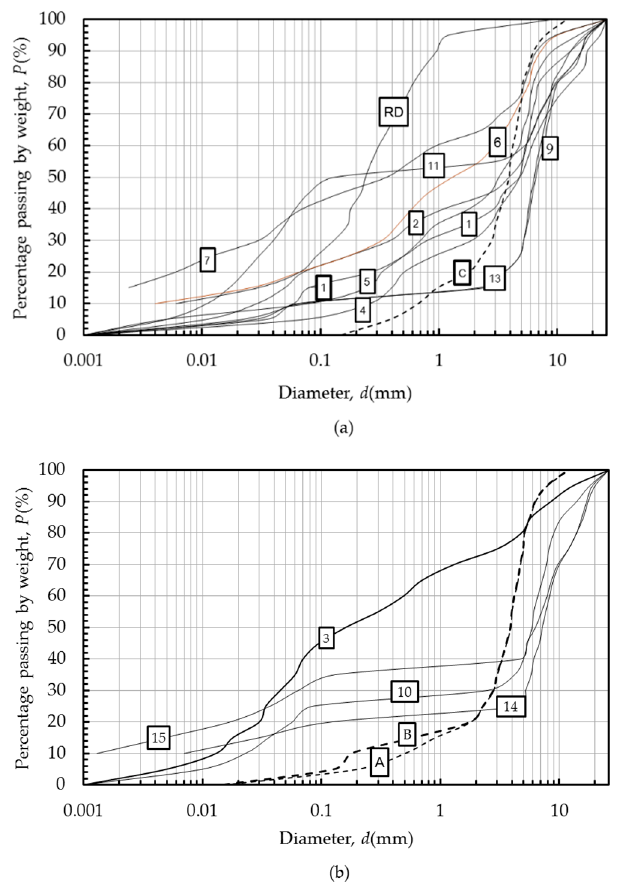
Figure 6. GSD curves of soils in ( a ) internal stable runs; ( b ) internal unstable runs in the studies of Skempton and Brogan [9] (dashed lines) and Wan and Fell [1] (solid lines).